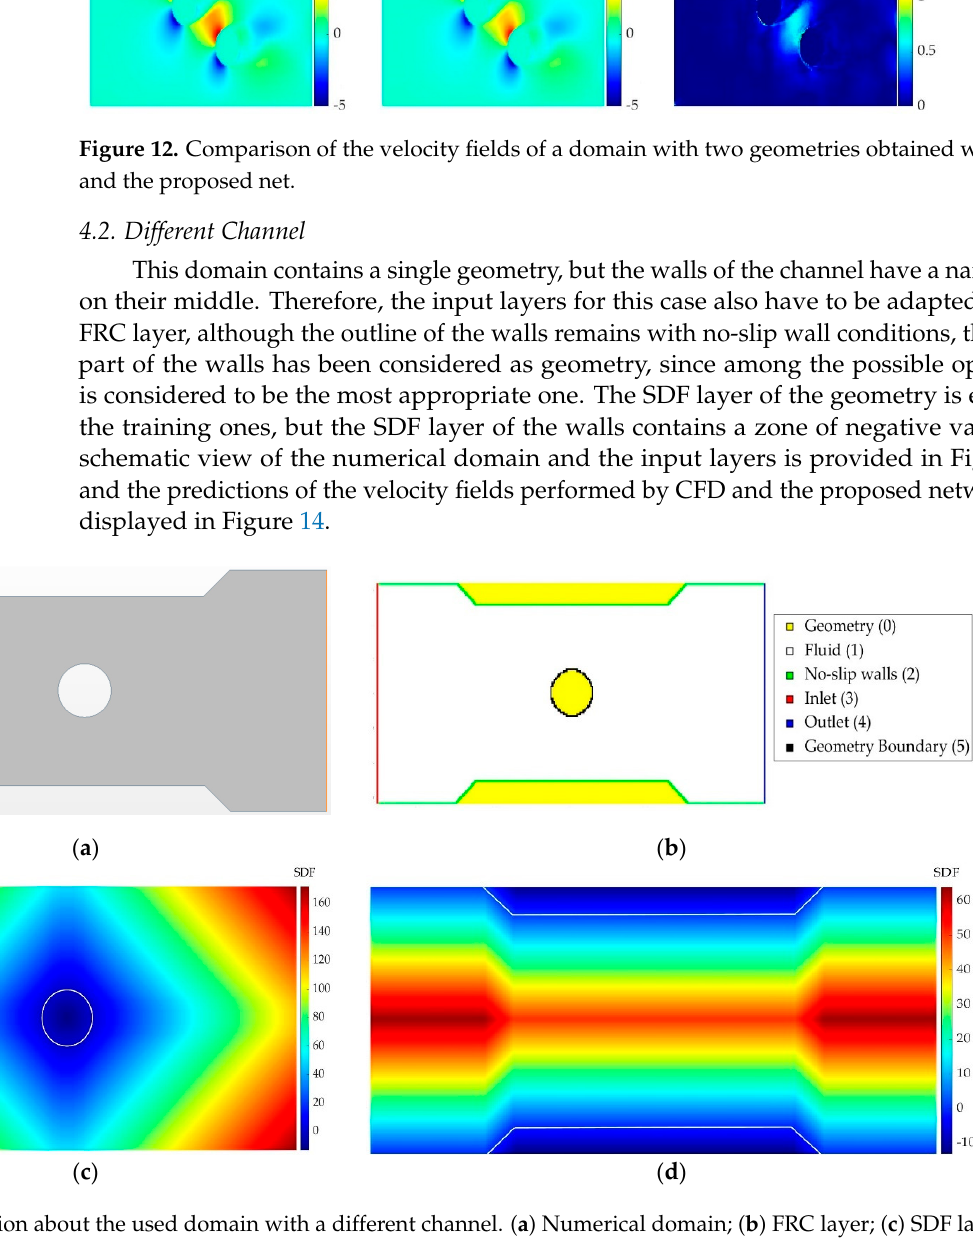
Figure 12. Comparison of the velocity fields of a domain with two geometries obtained with CFD and the proposed net.